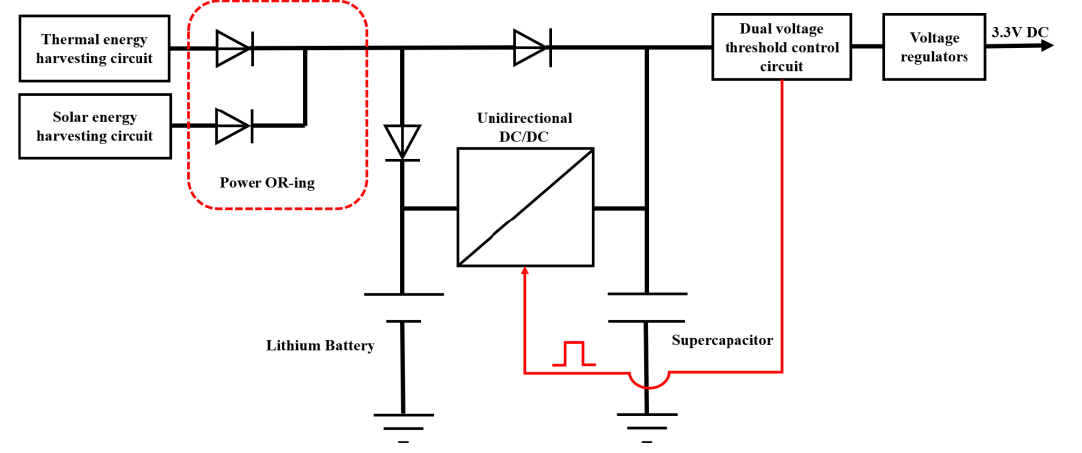
Figure 4. Schematic diagram of the hybrid energy storage subsystem.